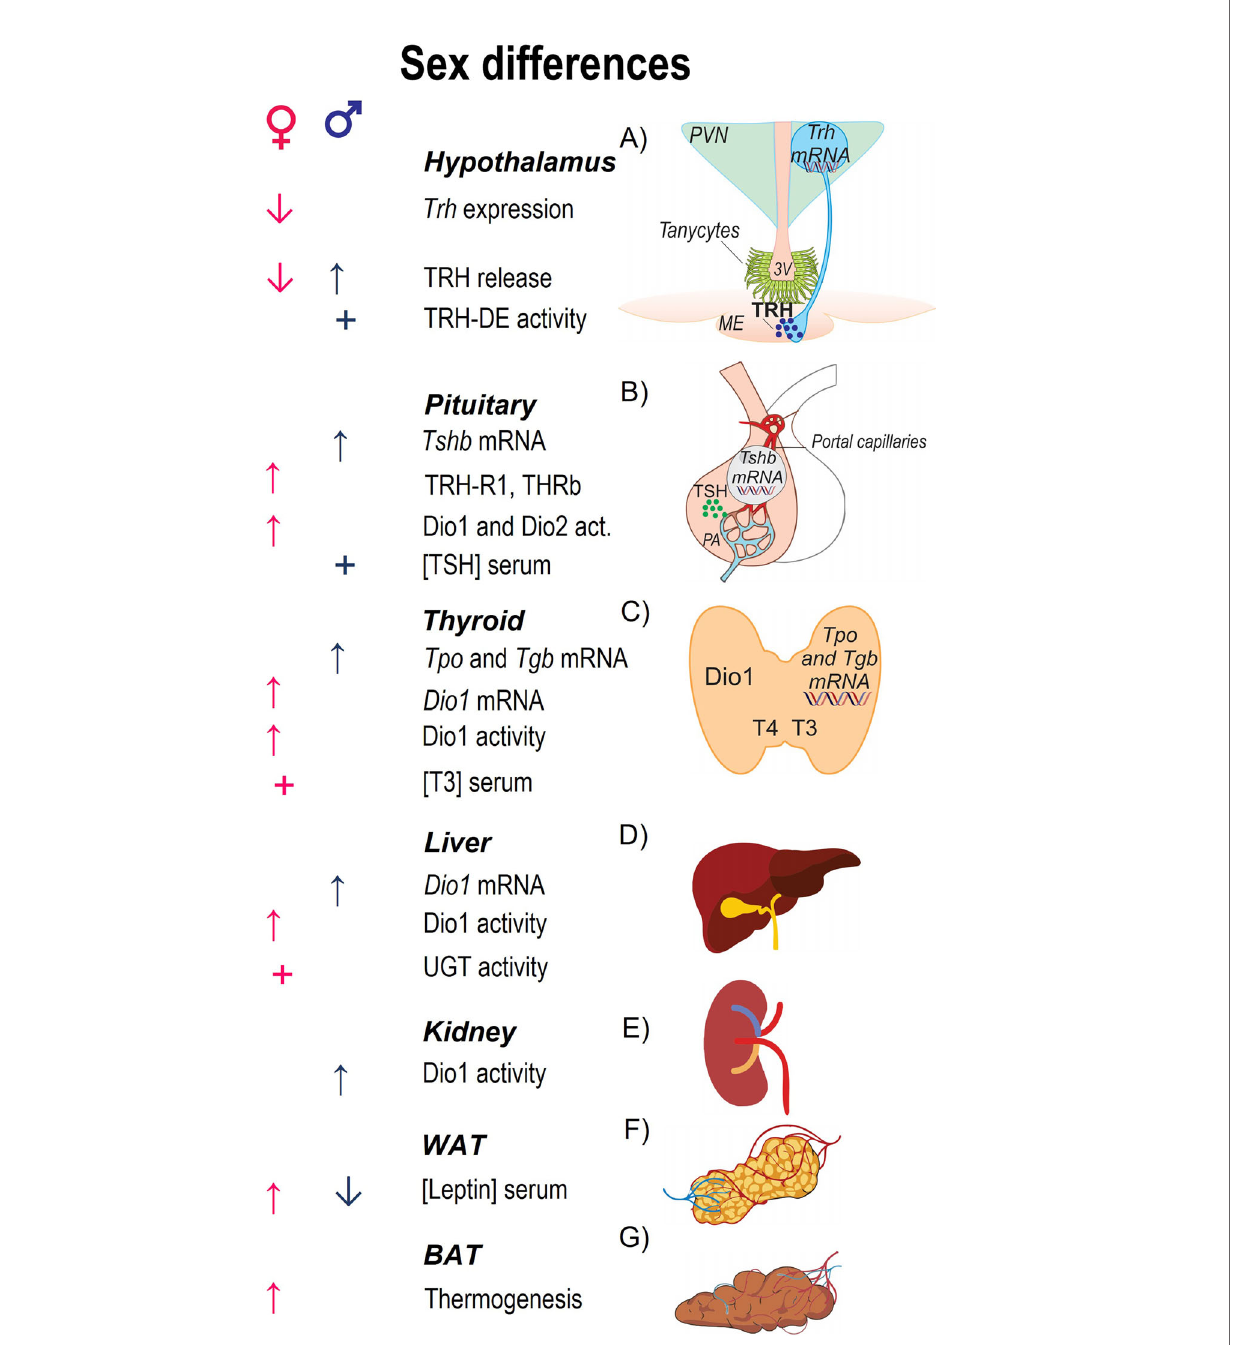
FIGURE 1 | Parameters involved in HPT axis activity and sex differences in basal conditions. The central panel enlists parameters that characterize each region of the axis; (A) Trh mRNA is expressed in the nuclei of hypophysiotropic cells that reside in the PVN of the hypothalamus, the protein precursor compartmentalized in vesicles that travel to the median eminence (ME) from where TRH is released; at the base of the third ventricle in the ME tanycytes express the TRH-degrading ectoenzyme (TRH-DE). (B) At the pituitary, TRH binds to its receptor TRH-R1 in the thyrotropes of the anterior pituitary stimulating the synthesis of the two subunits, TSH a and TSH b , and TSH release to the portal circulation. (C) At the thyroid, TSH stimulates TH synthesis, after uptake of iodine by sodium-iodine symporter it is oxidized by thyroid peroxidase (TPO) and added to tyrosyl residues of thyroglobulin (TGB); TSH also stimulates release of TH (70% T4 and 30% T3). (D, E) Circulating T3 is contributed by T4-deiodination by Dio1 in liver and kidney. TH clearance is due to glucuronidation and sulfatation in liver and excretion by kidney. (F) Leptin regulates the activity of HPT axis promoting the expression of Trh in PVN. (G) TH promote facultative thermogenesis inducing the expression of uncoupling proteins in BAT. Arrows indicate stimulation ( ↑ ) or inhibition ( ↓ ) by sex steroids (testosterone in males; estradiol in females). + indicates that this parameter is greater according to sex.